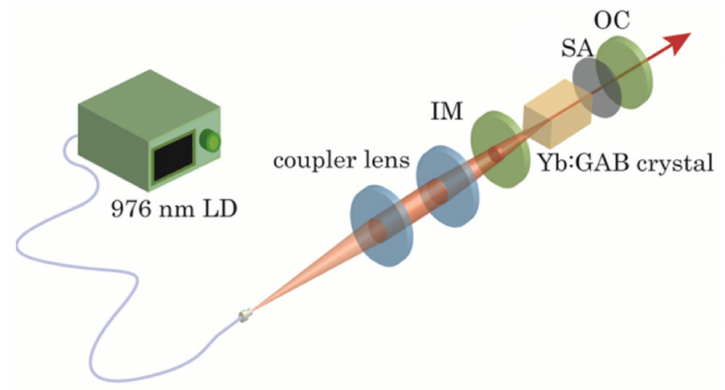
Figure 1. The experimental setup of the passively Q-switched Yb 3+ : GAB laser.